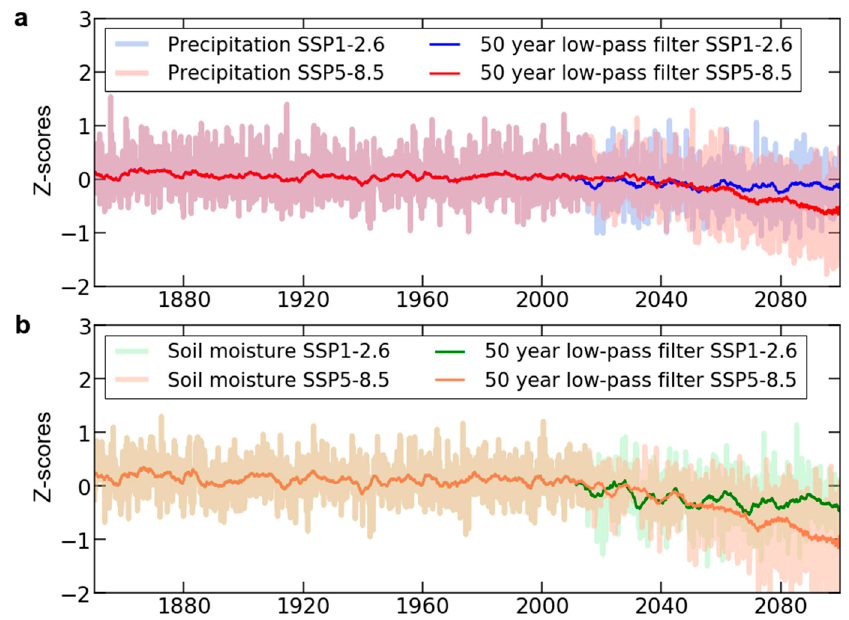
Figure 3. Multi-model means of projected changes in precipitation and surface soil moisture. ( a ) Trends of precipitation following the SSP1-2.6 and SSP5-8.5 warming scenarios. ( b ) as in (a) but for surface soil moisture (soil’s upper 10 cm). For display purposes, for each climate variable, we ap- pended historical simulations (1850–2015) to each of the projected simulations following the SSP1-2.6 and SSP5-8.5 warming scenarios (2015–2100).